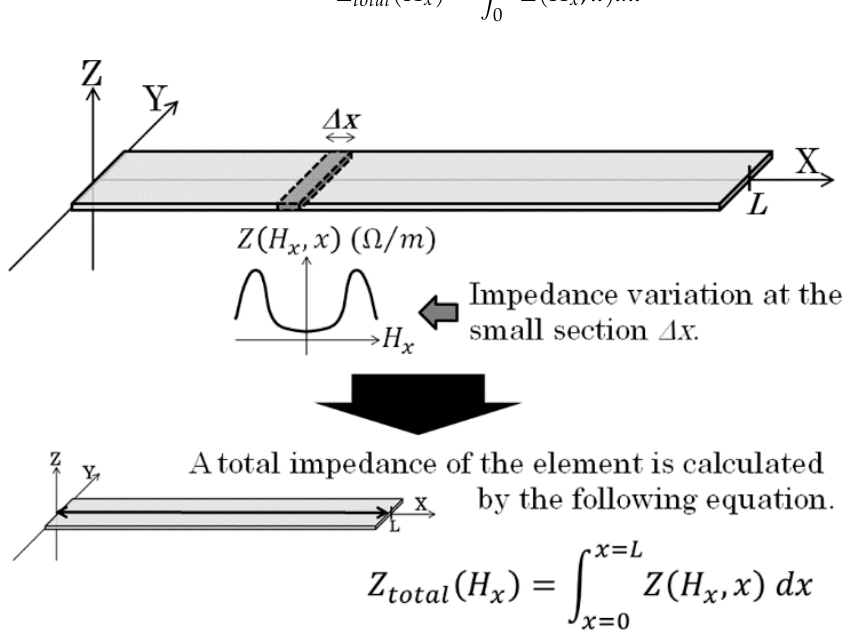
Figure 8. Schematic explanation of integral formula for the effect of field distribution on sensor impedance [21].